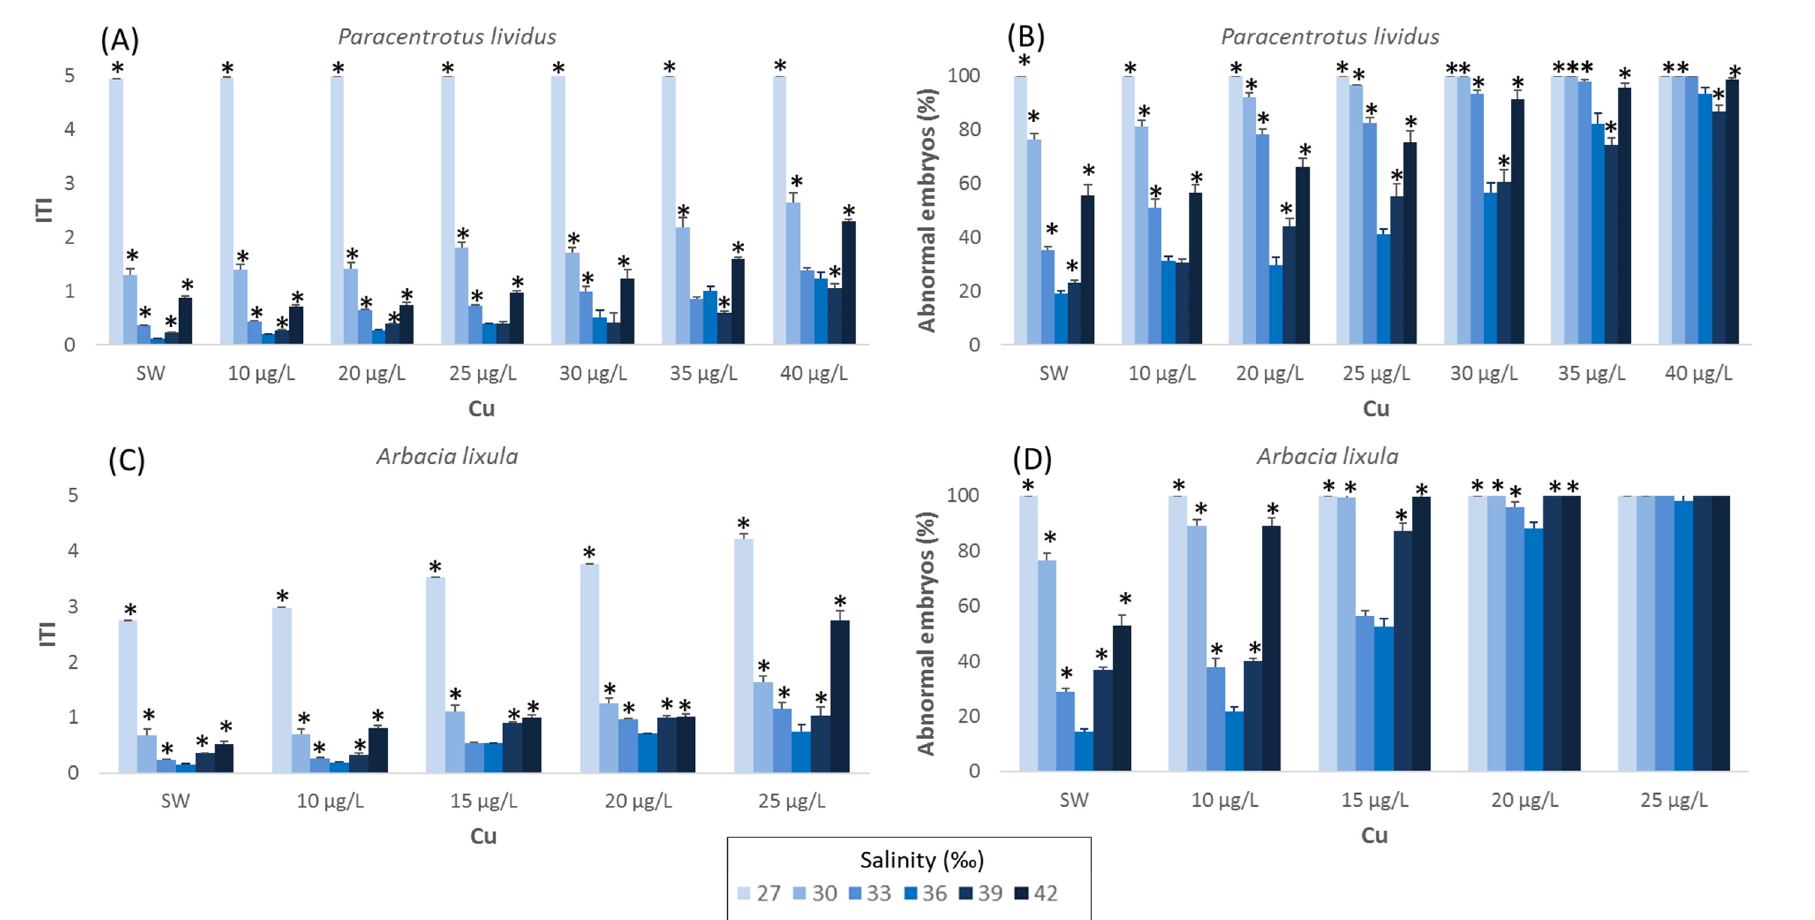
Figure 1. Effects of salinity on larval development at different Cu concentrations (SW indicates sea water without copper addition). Data are expressed as mean percentage of abnormal embryos (±standard error) (( A ) Paracentrotus lividus , ( B ) Arbacia lixula ) and as ITI (( C ) Paracentrotus lividus , ( D ) Arbacia lixula ). Note : The asterisk (*) indicates significant differences ( p < 0.05) between the standard salinity of 36 ‰ and other salinities.